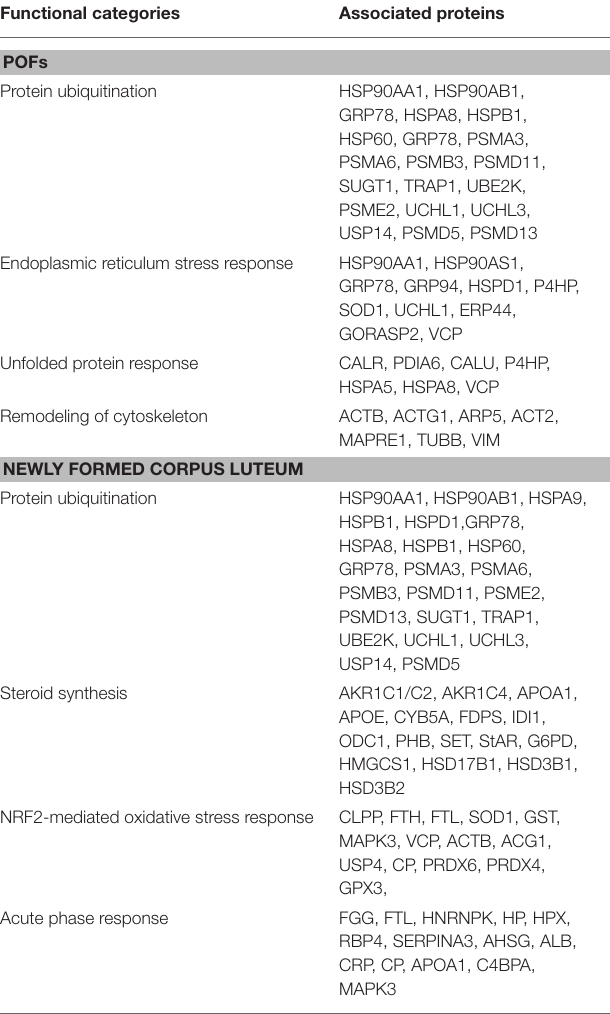
TABLE 1 | Functional categories and their associated proteins that are highly represented in POFs and the corpus luteum. Functional